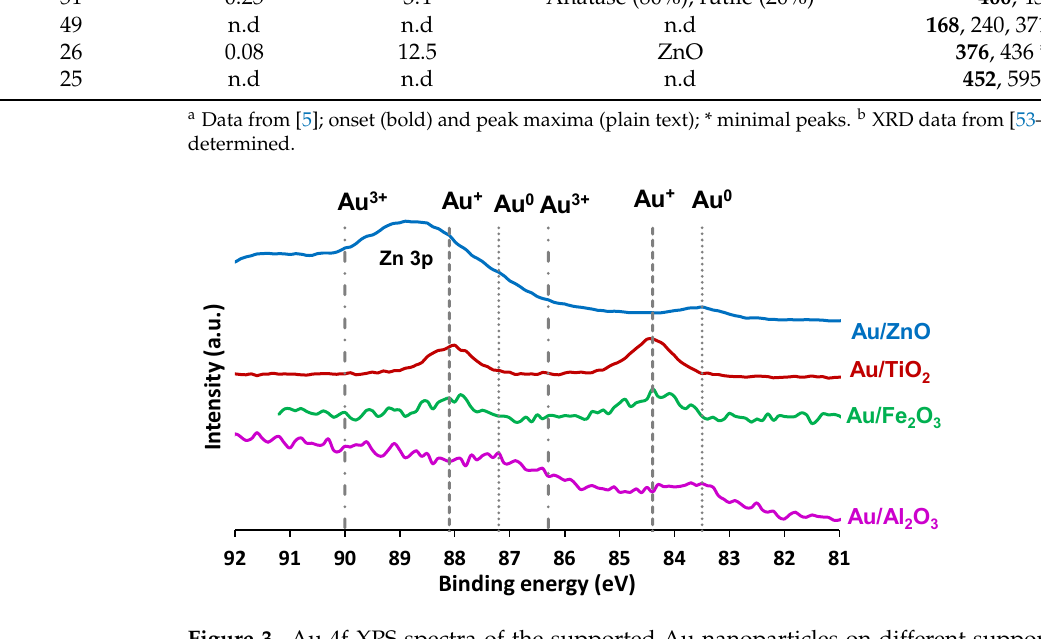
Figure 3. Au 4f XPS spectra of the supported Au nanoparticles on different supports. Adapted from [5] with permission from Wiley.